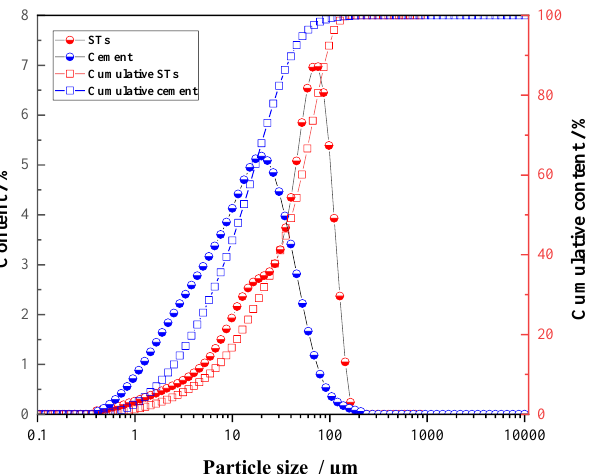
Figure 1. Particle size distribution curve of M32.5 cement and STs.